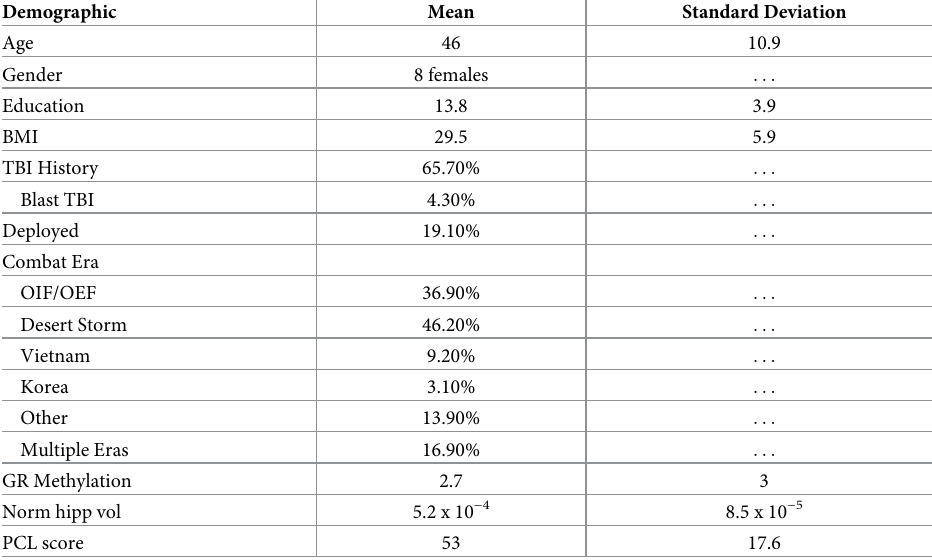
Table 1. Descriptive characteristics of the sample (n =